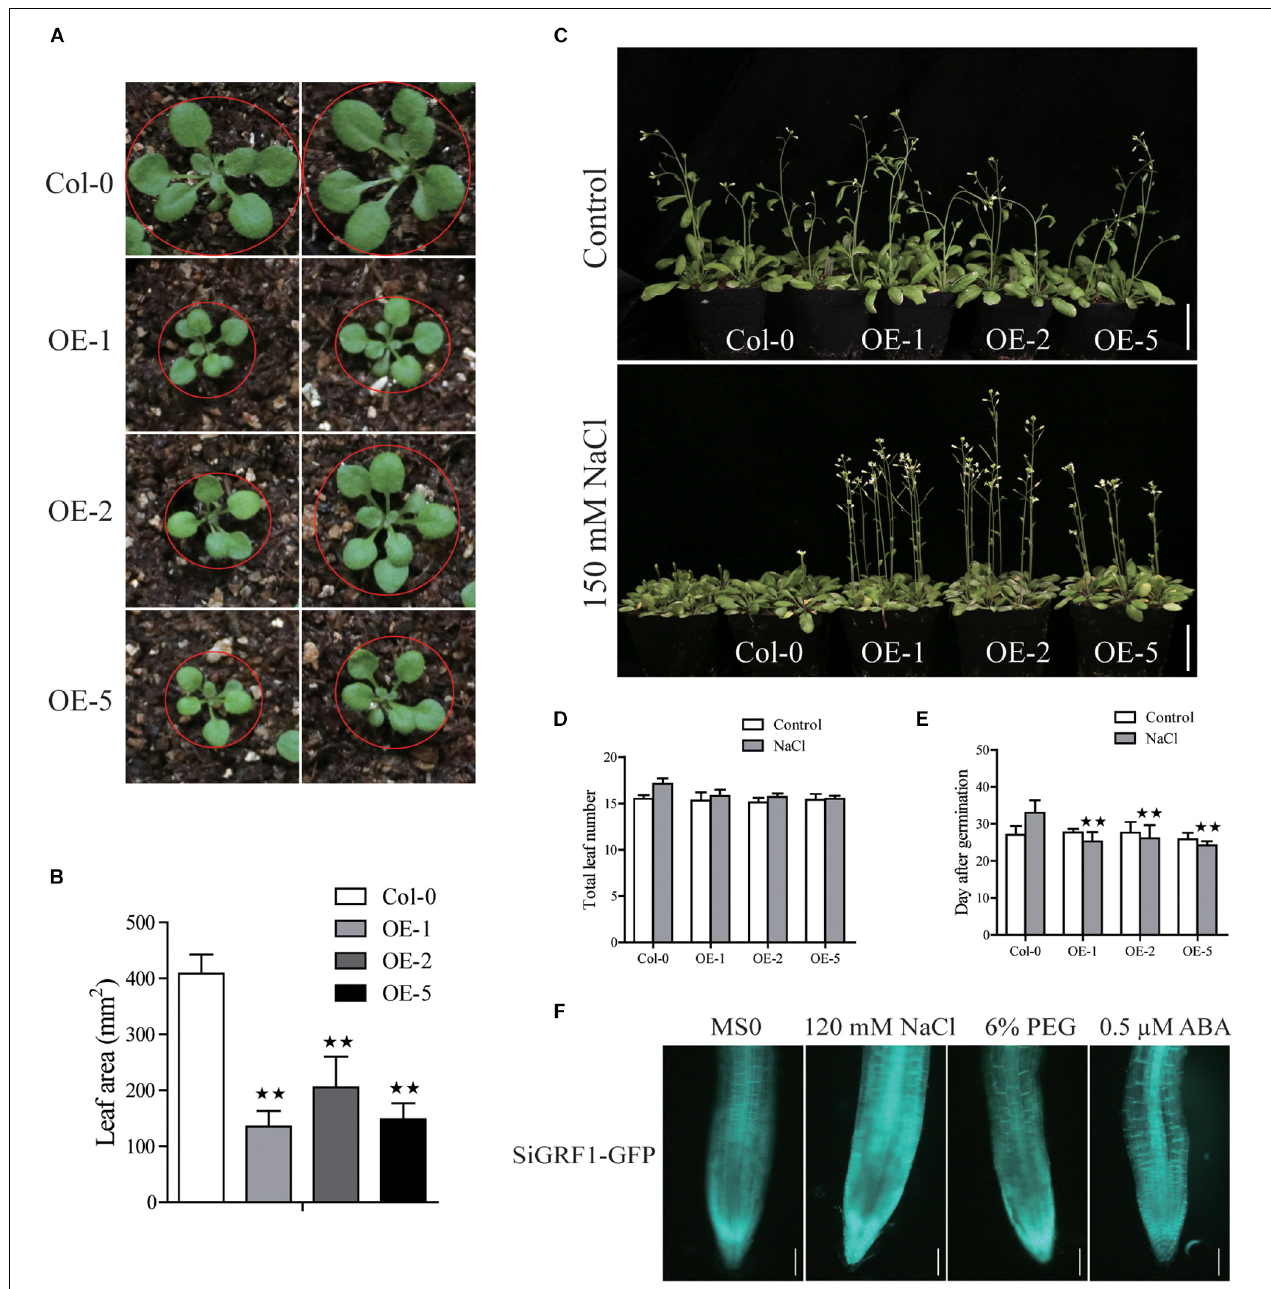
FIGURE 5 | Phenotype analysis of SiGRF1 -OEs. (A,B) SiGRF1-OE s have a smaller leaf size compared to that of the wild-type (Col-0) under the non-stressed condition. Bars = 1 cm. (C) The flowering time of SiGRF1-OE s under no stress and high salt stress. Bars = 5 cm. (D,E) Flowering days and number of leaves at flowering of SiGRF1-OE s under no stress and high salt stress. Data represent means ± SD ( n = 100). (F) The GFP fluorescence signal of SiGRF1-OE s when plants were grown on MS medium with or without treatment of 120 mM NaCl, 6% PEG, or 0.5 µ M ABA for 1 h. Bars = 0.1 cm. Asterisks (* and **) indicate significant differences (* P < 0.05 and ** P < 0.01) compared with Col-0 (Student’s t -test).